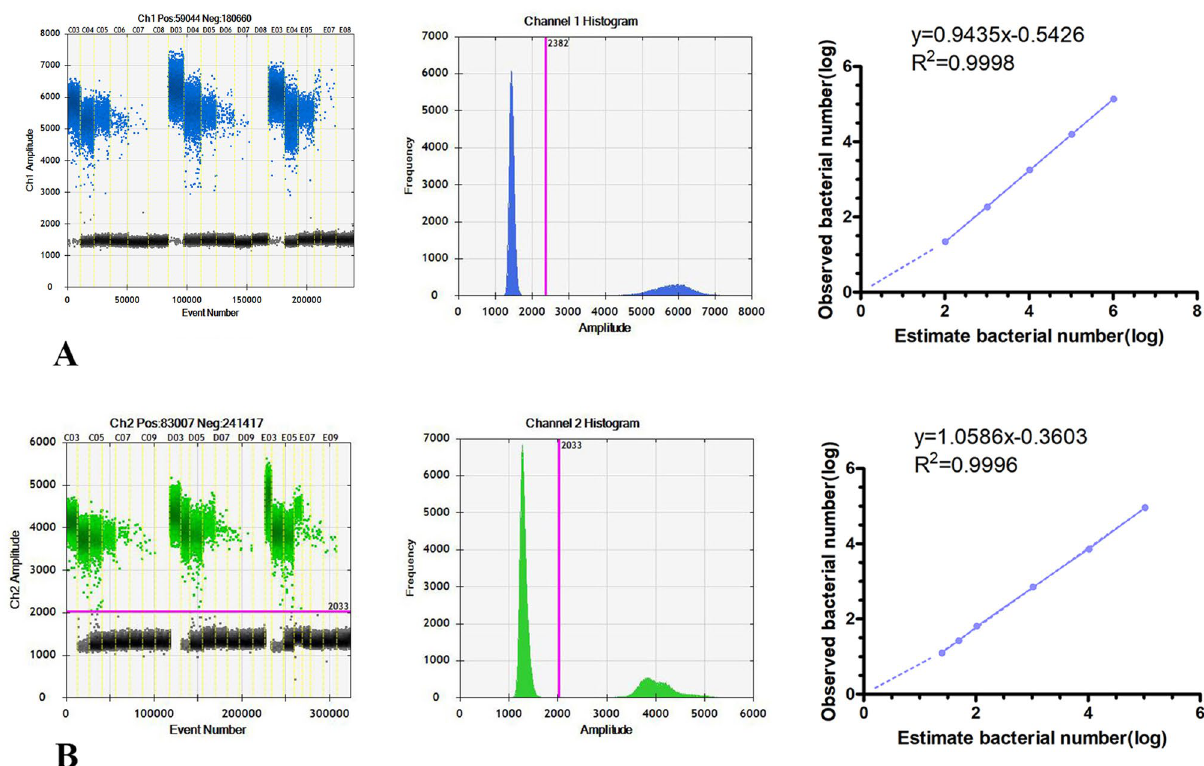
Figure 4. The dynamic range of the ddPCR-based assay for detection of a simulated bacteremia blood sample. ( A ) The 1D droplet spots of FAM fluorescence amplitude for six detection sites for Escherichia coli ATCC25922 (from C03-C08, D03-D08, E03-E08: the estimated bacterial counts were 1.04 × 10 6 , 1.04 × 10 5 , 1.04 × 10 4 , 1.04 × 10 3 , 1.04 × 10 2 , and NC ) were performed for each detection site. Linear fitting lines are shown on the right. ( B ) The 1D droplet spots of VIC fluorescence amplitude for eight detection sites for Staphylococcus aureus ATCC25923 (from C03-C10, D03-D10, E03-E10: the estimated bacterial counts were 1.04 × 10 6 , 1.04 × 10 5 , 1.04 × 10 4 , 1.04 × 10 3 , 1.04 × 10 2 , 50, 25 and NC) were performed for each detection site. Linear fitting lines are shown on the right. Error bars represent the standard deviation of three replicate samples at each target bacterial count.